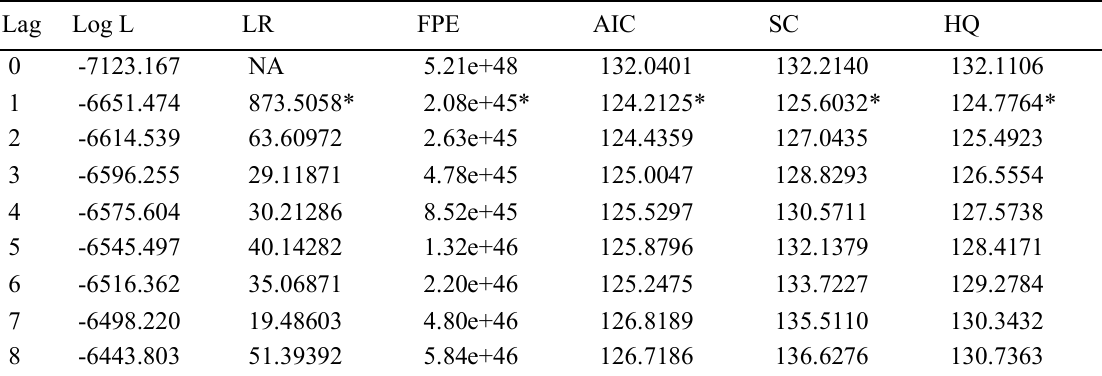
Table 3. Results of the test to determine optimal lag for